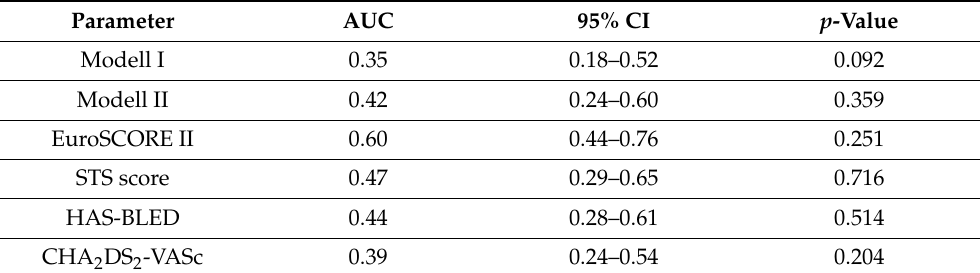
Table 6. Comparison of risk scores in CVE prediction after TAVR (validation